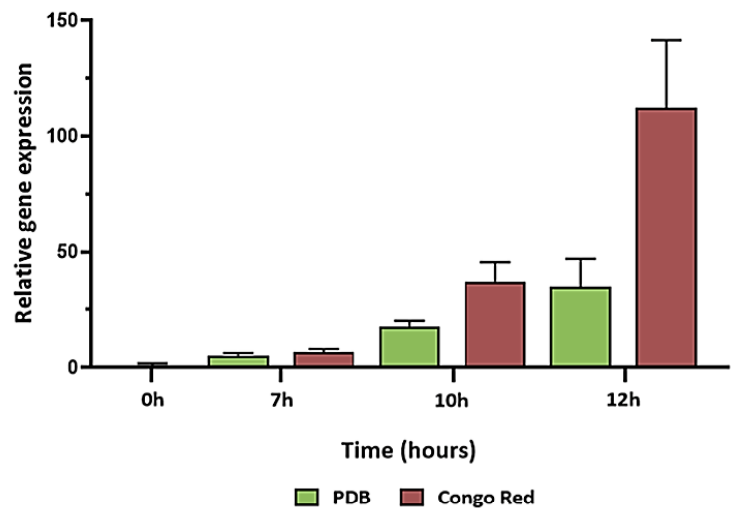
Figure 9. Expression levels calculated as of gel3 during germination in PDB and in the presence of 500 µ M Congo Red. Gene expression was determined by RT-PCR. Values shown are based on three biological repeats, with whiskers signifying one standard error. Gene expression was normalized to tef1 . The threshold cycle (2 − ∆∆ CT ) method was used to determine fold changes in expression. Standard errors (whiskers) were based on three biological